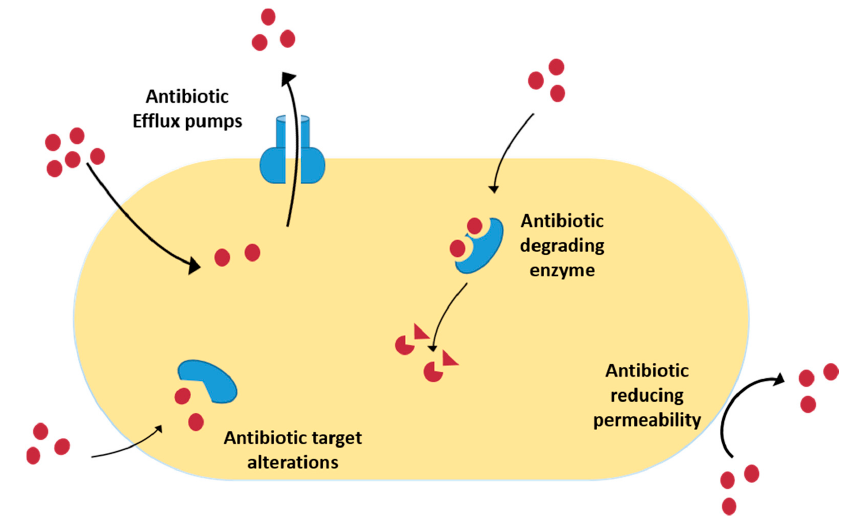
Figure 1. Mechanisms involved in bacterial resistance to antibiotics.